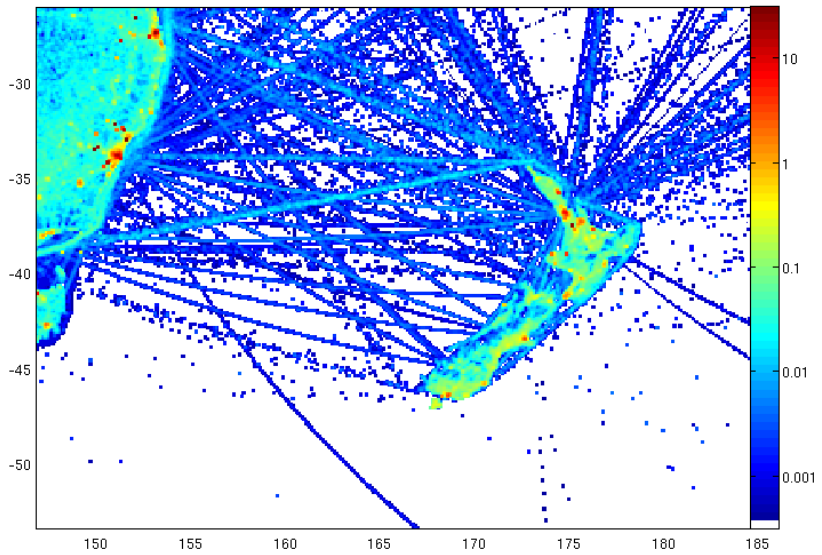
Figure 6. Gridded fossil emissions of CO 2 across the model domain and averaged over 2011–2013, in kgCO 2 m − 2 yr − 1 . Emissions are based on EDGAR v4.2, with 2011–2013 estimates extrapolated from the 2000–2010 trend in global total